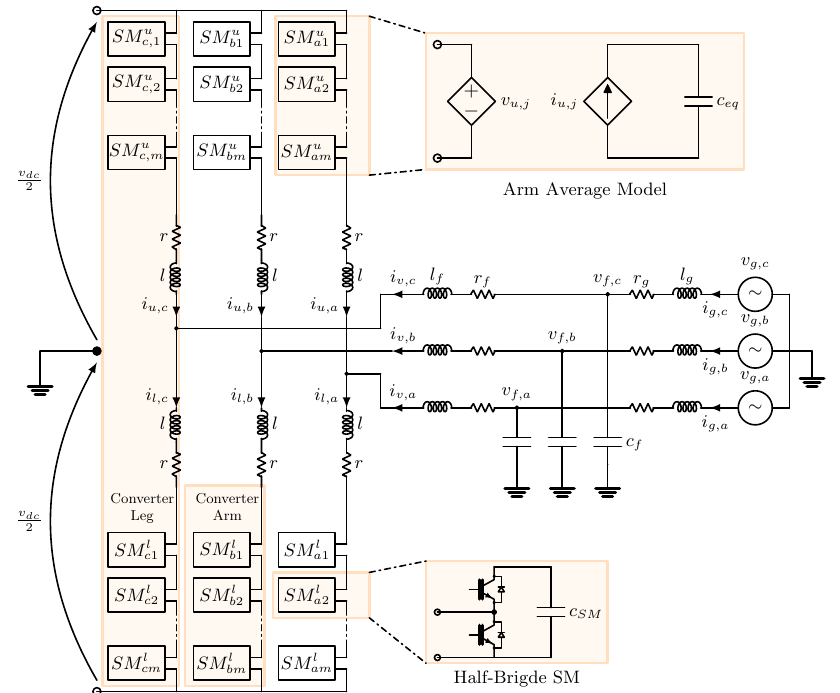
Figure 1. Model of an MMC-HVDC inverter terminal connected to the electric grid.